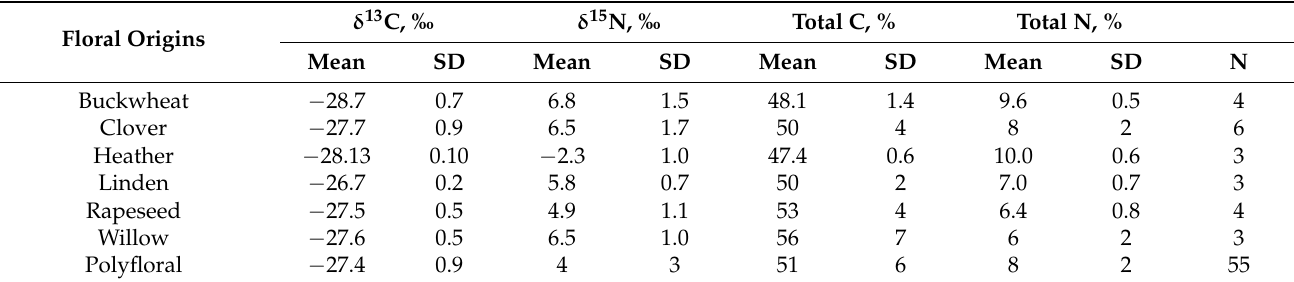
Table 1. IRMS analyses results by floral origins of